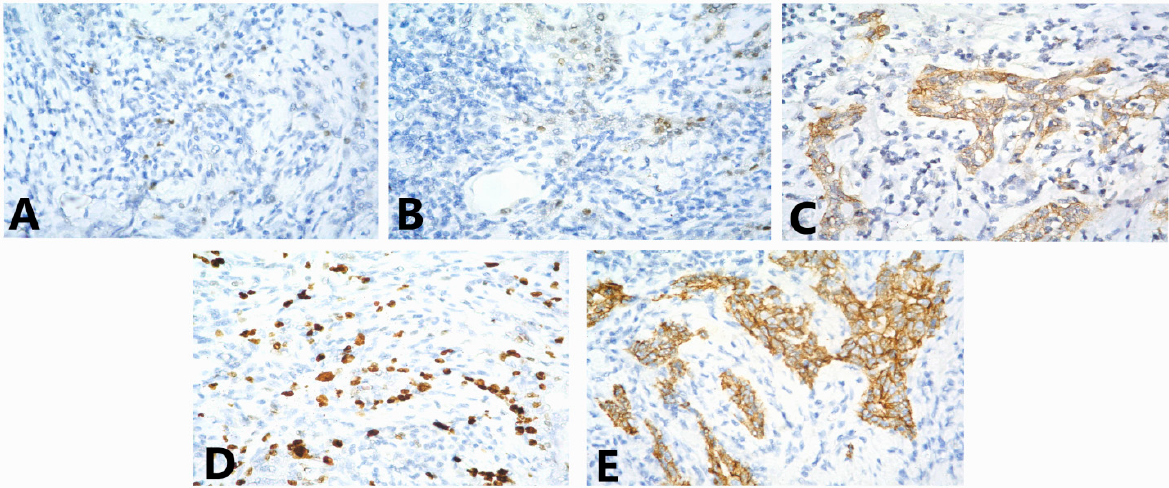
Figure 6. Immunostaining for ( A ) ER (weak nuclear staining in about 10% of the tumor cells, 40x); ( B ) PgR (weak nuclear staining in about 10% of the tumor cells, 40x); ( C ) HER2 (evaluated as 2+—moderately intensive, complete membrane staining, 40x); ( D ) Ki-67 index—30%, 40x; ( E ) E-cadherin (moderately intense staining of the cell membranes of the tumor cells, 40x).